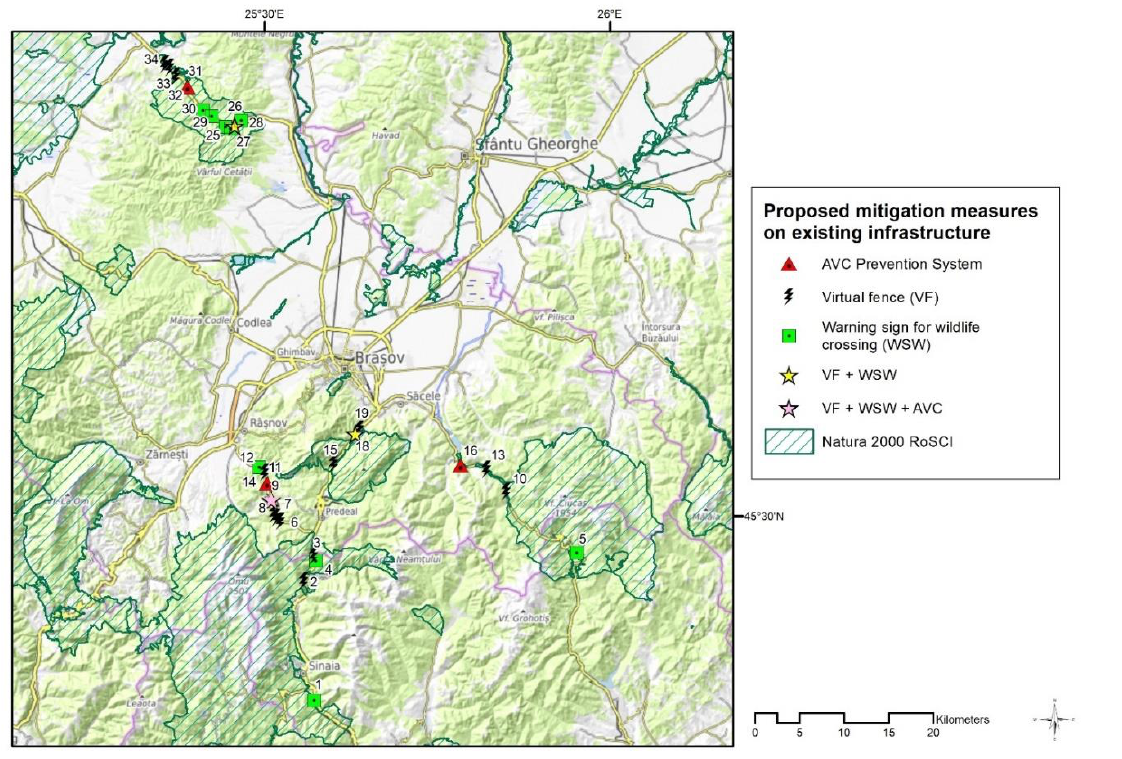
Figure 6. WVC hotspot and the mitigation measures proposed on the existing infrastructure.